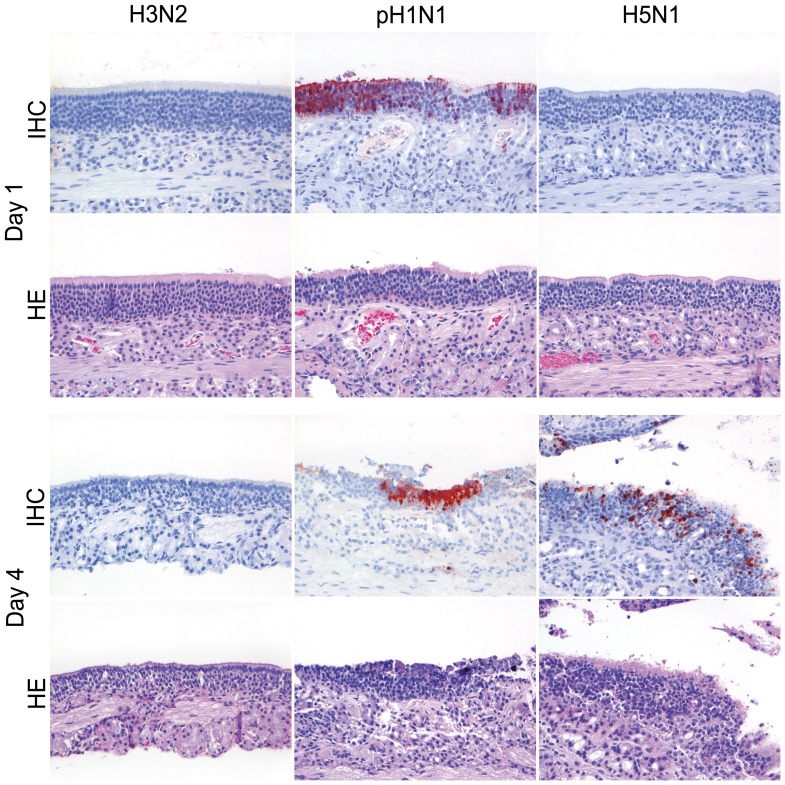
Antigen expression and histopathology of nasal olfactory epithelium of ferrets inoculated with different influenza viruses.There is high antigen expression with associated lesions characterized by neutrophilic rhinitis in the olfactory epithelium of ferrets inoculated with pH1N1 on 1 and 4 dpi, and for H5N1 only on 4 dpi. There were no antigen expression and no lesions for H3N2. HE and immunoperoxidase counterstained with hematoxylin, 200×.